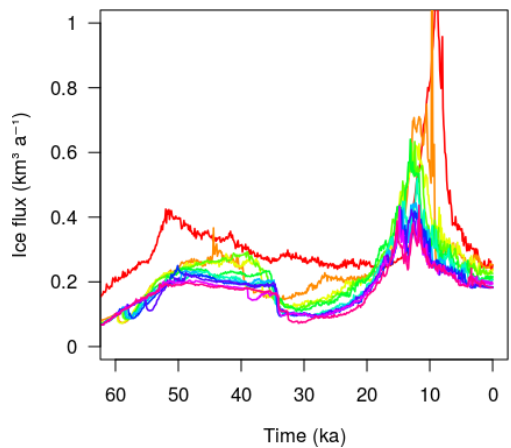
Figure 5. Simulated ice flux at the NEGIS sector for different oceanic forcings. Colours refer to the colour scale of Fig.